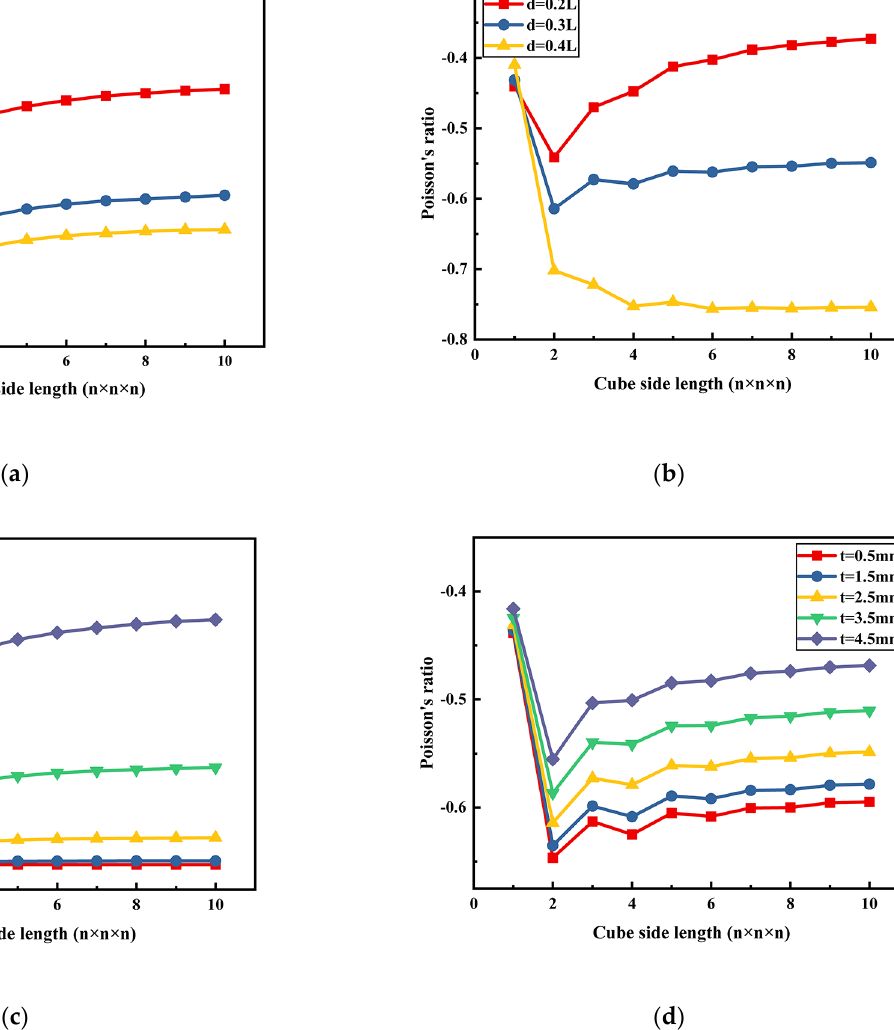
Figure 12. Mechanical properties of the auxetic lattice: ( a ) The relationship between the elastic modulus and the cube side length (d = 0.2 L~0.4 L); ( b ) The relationship between the Poisson’s ratio and the cube side length (d = 0.2L~0.4 L); ( c ) The relationship between the elastic modulus and the cube side length (t = 0.5 mm~4.5 mm); and ( d ) The relationship between the Poisson’s ratio and the cube side length (t = 0.5 mm~4.5 mm).